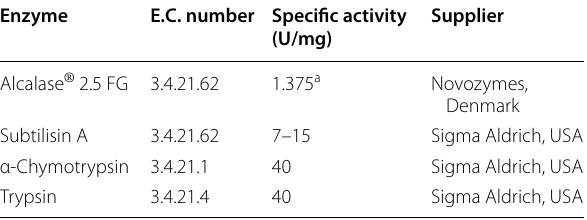
Table 1 Proteolytic enzymes for protein